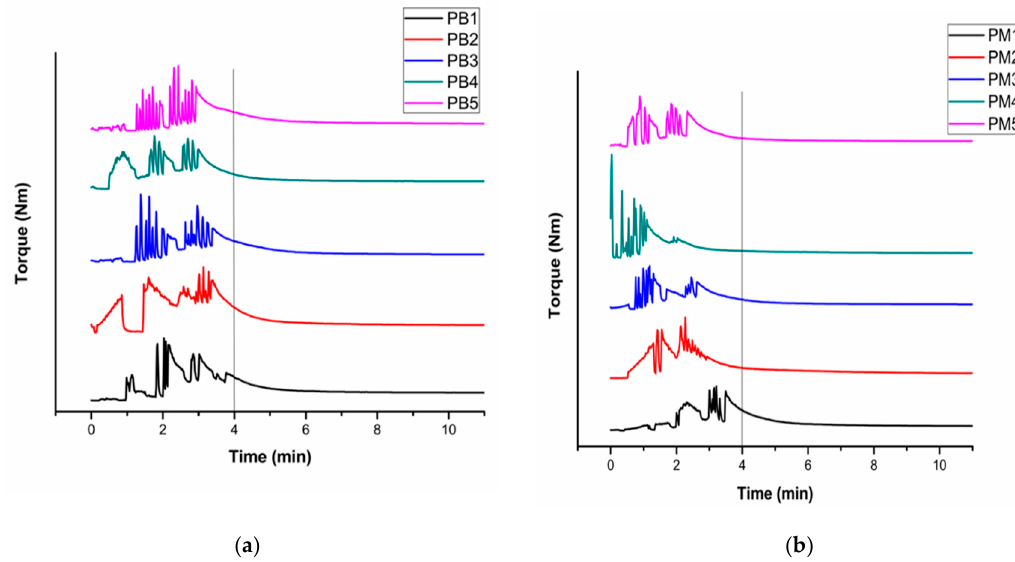
Figure 1. Torque variation of PP with reaction time by altering ( a ) BPO concentration and ( b ) MAH concentration.